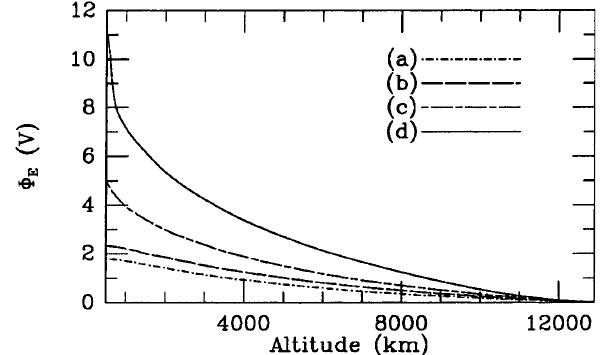
Fig. 10. Profiles of the self-consistent ambipolar electric potential. The labels correspond to the cases listed in Table 3